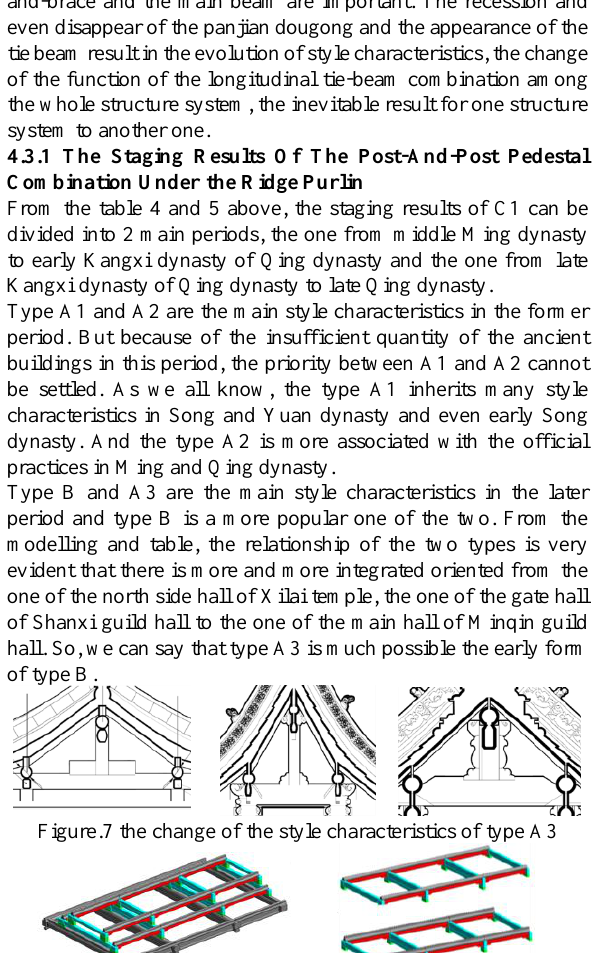
Figure.7 the change of the style characteristics of type A3